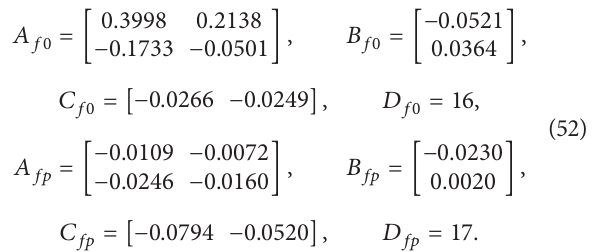
Algorithm 13. The gain-scheduled filter design